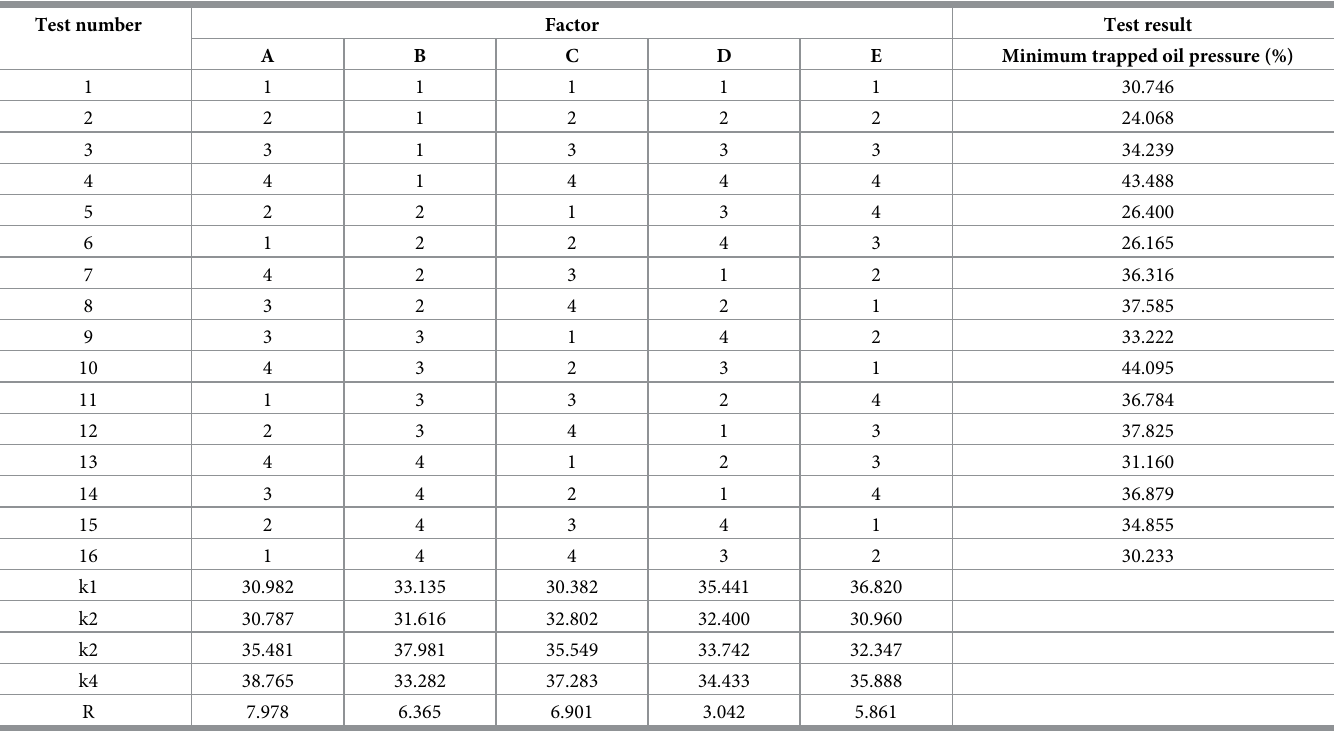
Table 9. Orthogonal test analysis table of the minimum trapped oil pressure.